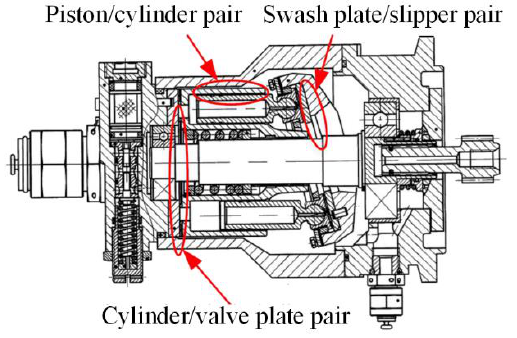
Figure 1. Sliding pairs in axial piston pump.